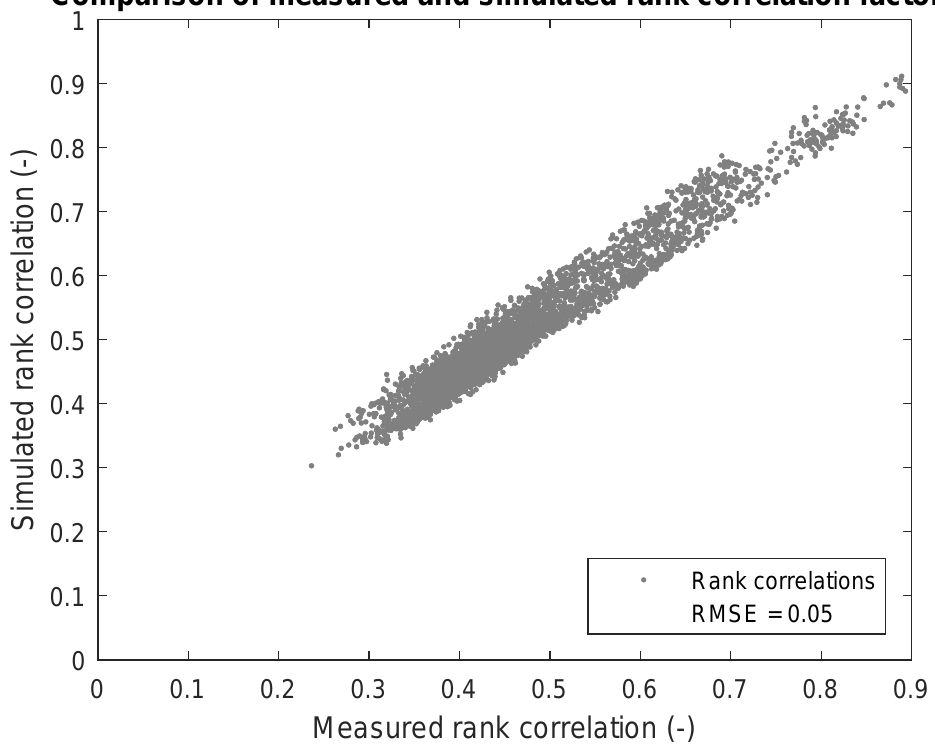
Figure 6. Plot showing the correlation between the actual measured values and the simulated